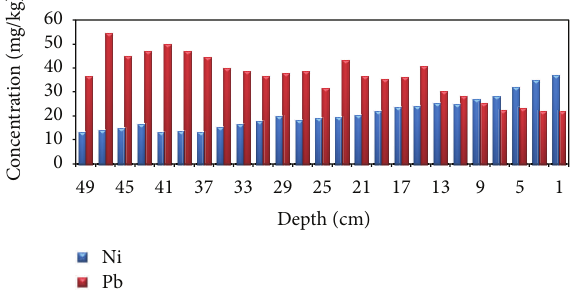
Figure 3: Clear upward variations of Ni and Fe in Bera Lake sediment column (Core 5).